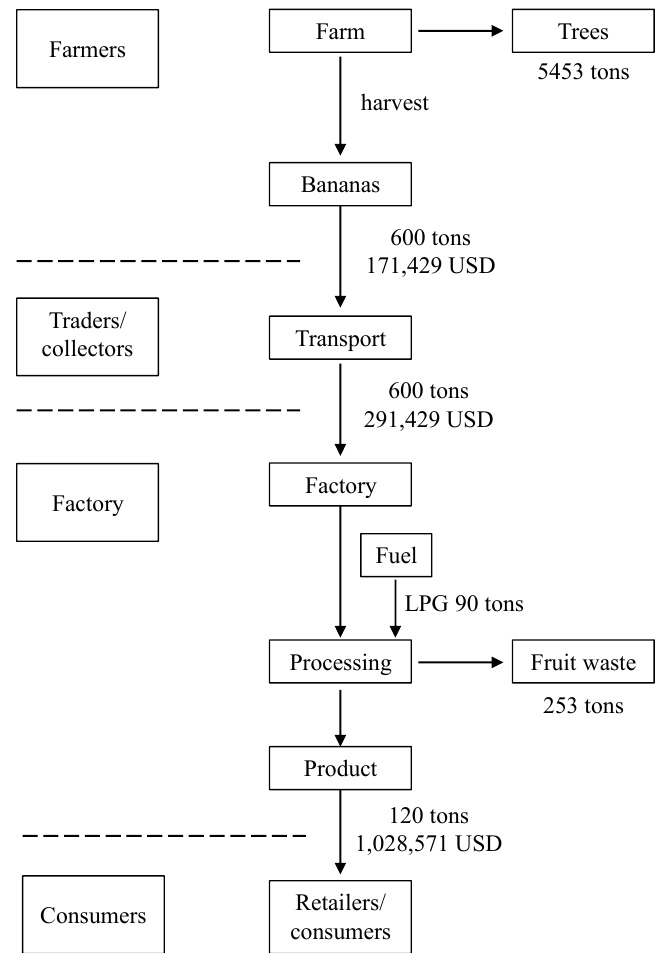
Figure 1. Banana chips value chain and material flow in business-as-usual case.